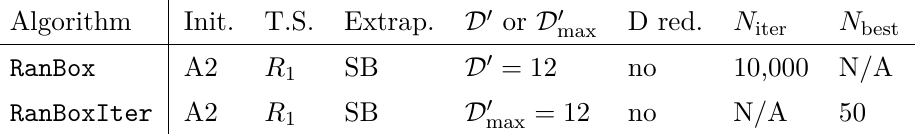
Table 2 . Run parameters of the RanBox and RanBoxIter algorithms for a test on the HEPMASS dataset with a 5% signal contamination. “Init.” indicates the method defining the initial dimension of the search box; “Extrap.” identifies the way by which a prediction of events in the box is computed; D 0 is the dimensionality of the subspaces scanned by RanBox , and D 0 the maximum dimension of the max subspaces constructed iteratively by RanBoxIter ; “Dim. red.” indicates whether the dimensionality of the feature space was reduced with PCA or by discarding the most correlated variables; N iter is the number of searched subspaces by RanBox ; and N is the number of feature combinations best considered by RanBoxIter when adding one dimension to the previous subspaces